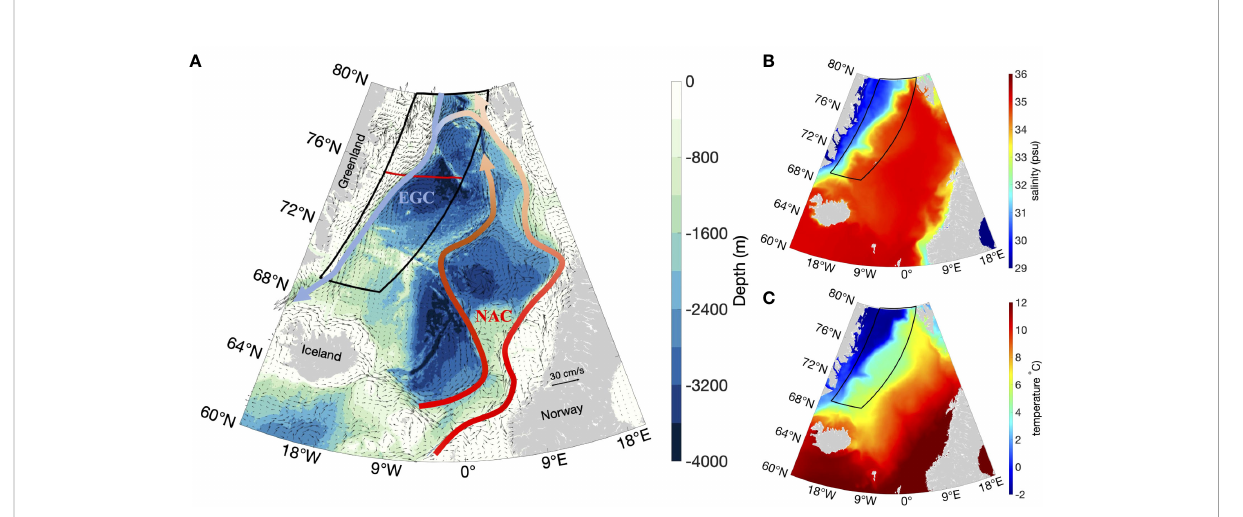
FIGURE1 Schematic of circulation (Raj et al., 2016; Våge et al., 2018; Huang et al., 2020) in the Nordic Sea and the study region (black boundaries). (A) Topography is from ETOPO1 (Amante and Eakins, 2009). The black arrows denote the 1993 – 2018 July climatological absolute geostrophic current fi eld from AVISO. The thick red gradient lines present the North Atlantic Current, and the thick gray-blue line presents the East Greenland Current. The thin red line is the section selected for further analysis of spatial relationship between the main position of EGPF and the ice edge (15% sea ice concentration). (B) Spatial distributions of the July climatological sea surface salinity. (C) Spatial distributions of the July climatological sea surface